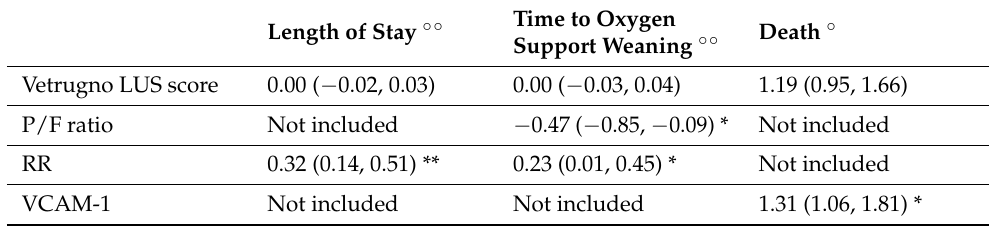
Table 7. Multivariate analysis of prognostic factors.